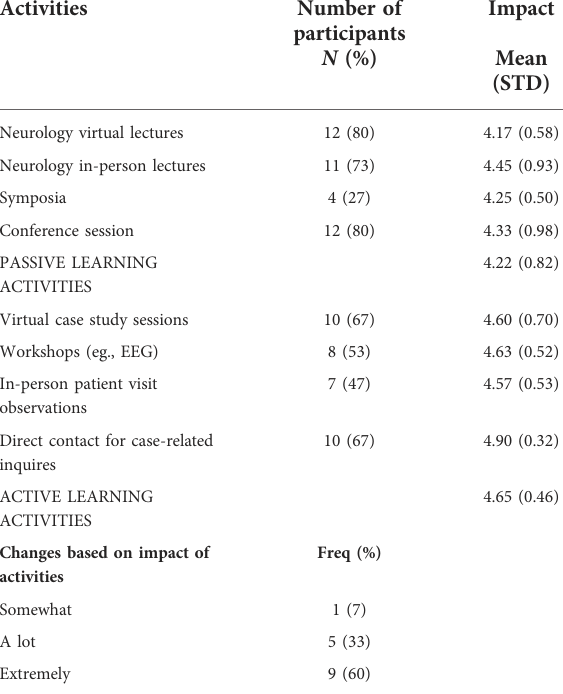
TABLE 5 Neurology provider